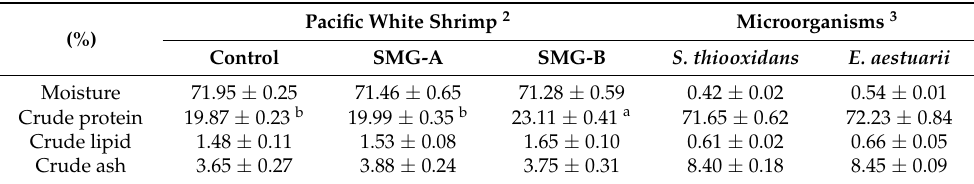
Table 2. Whole-body proximate compositions of the Pacific white shrimp cultured in the control, SMG-A, and SMG-B groups after 6 weeks of culture 1 .